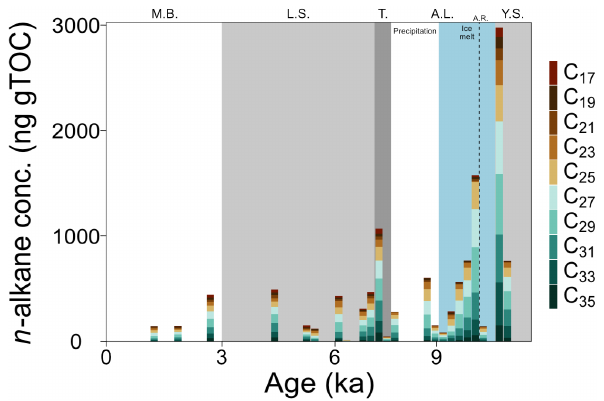
Figure 4. TOC weighted concentrations of C 17 –C 35 n -alkanes in core 64PE410_S7 ( n = 22). Concentrations were highest in the Yoldia Sea brackish phase and lowest in the modern Baltic. Phases are abbreviated as follows: Y.S.: Yoldia Sea, A.L.: Ancylus Lake, T.: marine transgression, L.S.: Littorina Sea, M.B.: modern Baltic, A.R.: Arkona Regression. New subdivisions for the AL phase showing the shift from ice-melt-derived to precipitation-dominated source water are shown in blue and